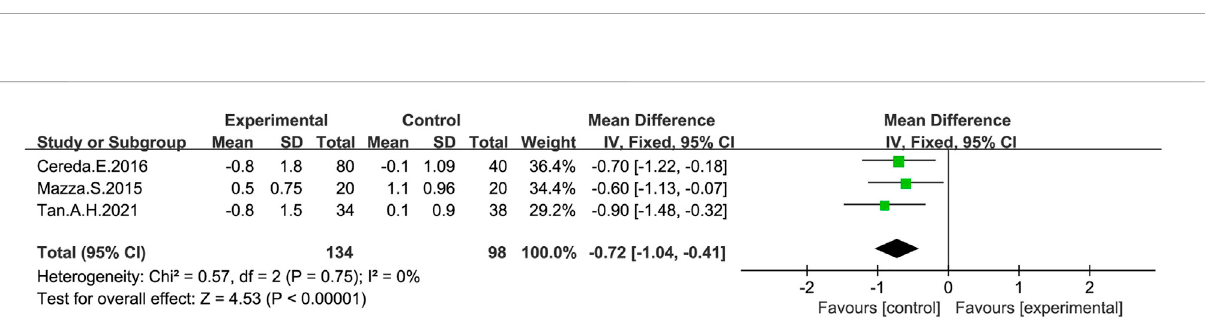
FIGURE 5 ForestplotofStoolconsistencyintheprobioticinterventiongroupversusthatofthecontrolgroup,arandom-effectsmodelwasusedtoanalyzeMDand 95% CI.